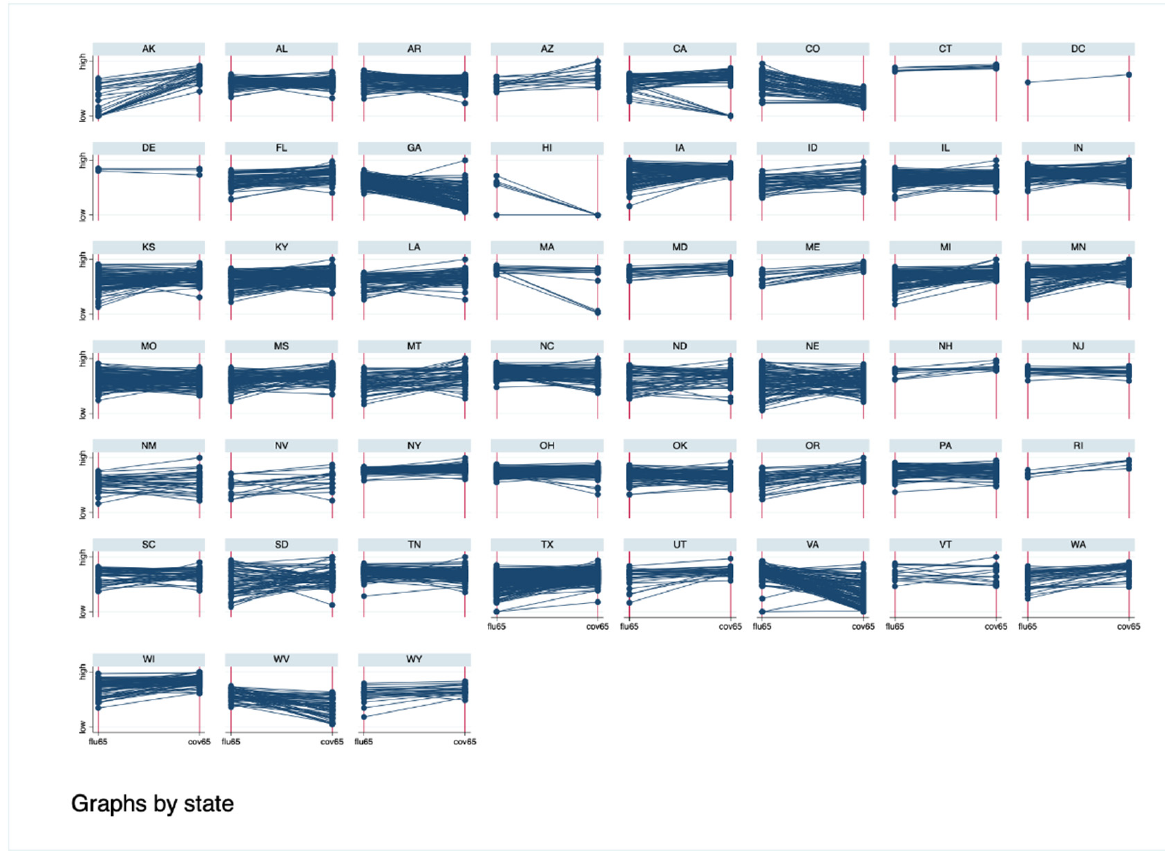
Figure 2. Slopegraphs comparing influenza vaccination rates ( left columns ) to COVID-19 vaccination rates ( right columns ). Each line represents a county within a state or territory.